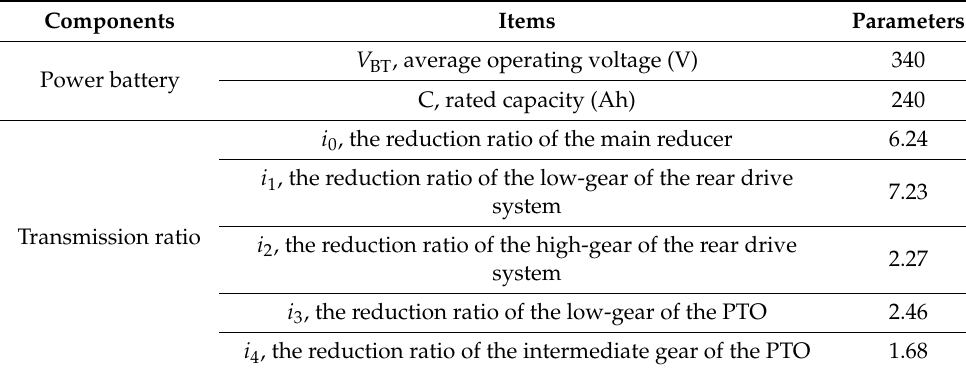
Table 4. The main parameters of battery package and transmission ratio.